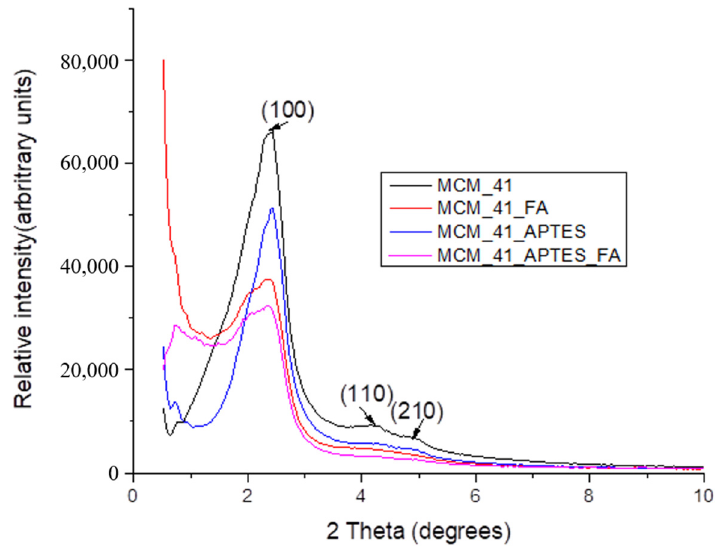
Figure 2. X-ray diffractograms for the MCM-41 based samples: MCM-41, MCM-41_FA, MCM- 41_APTES and MCM-41_APTES_FA.